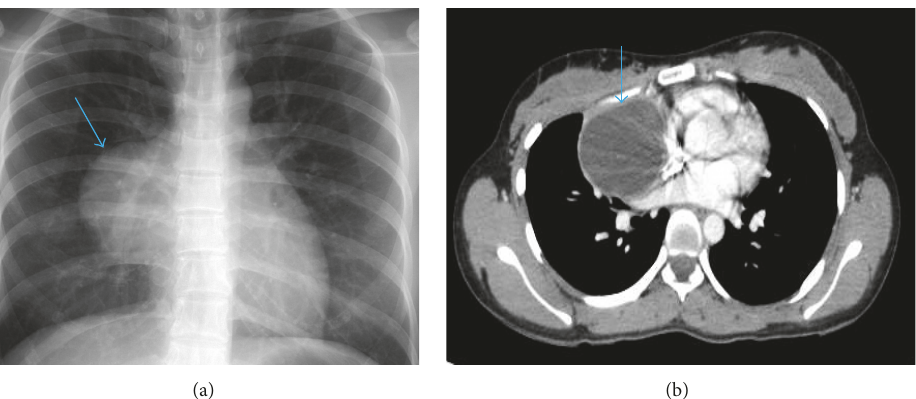
Figure 1: (a) Chest X-ray showed 6 × 4.5cm white opaque lesion in mediastinal area (blue arrow) and (b) CT-scan revealed hypodense mass 6.7 × 7.5 cm, suggesting inferoanterior mediastinal cyst (blue arrow). Encapsulated cystic lesion compressed adjacent aorta and pericardium.